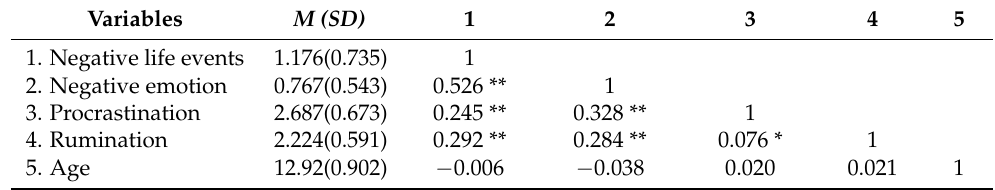
Table 1. Descriptive statistics and interrelations among all of the observed variables and age.